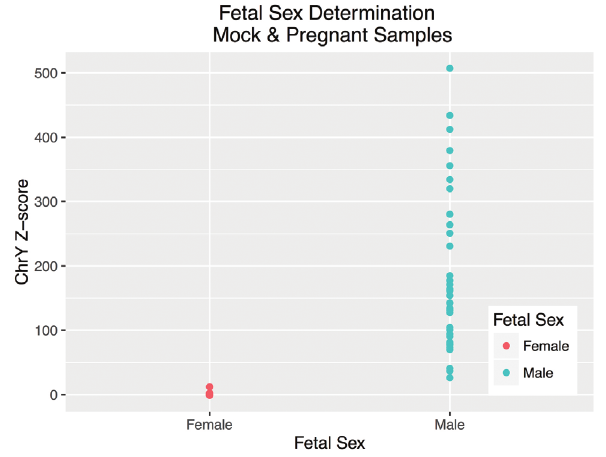
Figure 3 - Fetal sex determination in 44 females and 37 males. Chromo- some Y Z-score according to fetal